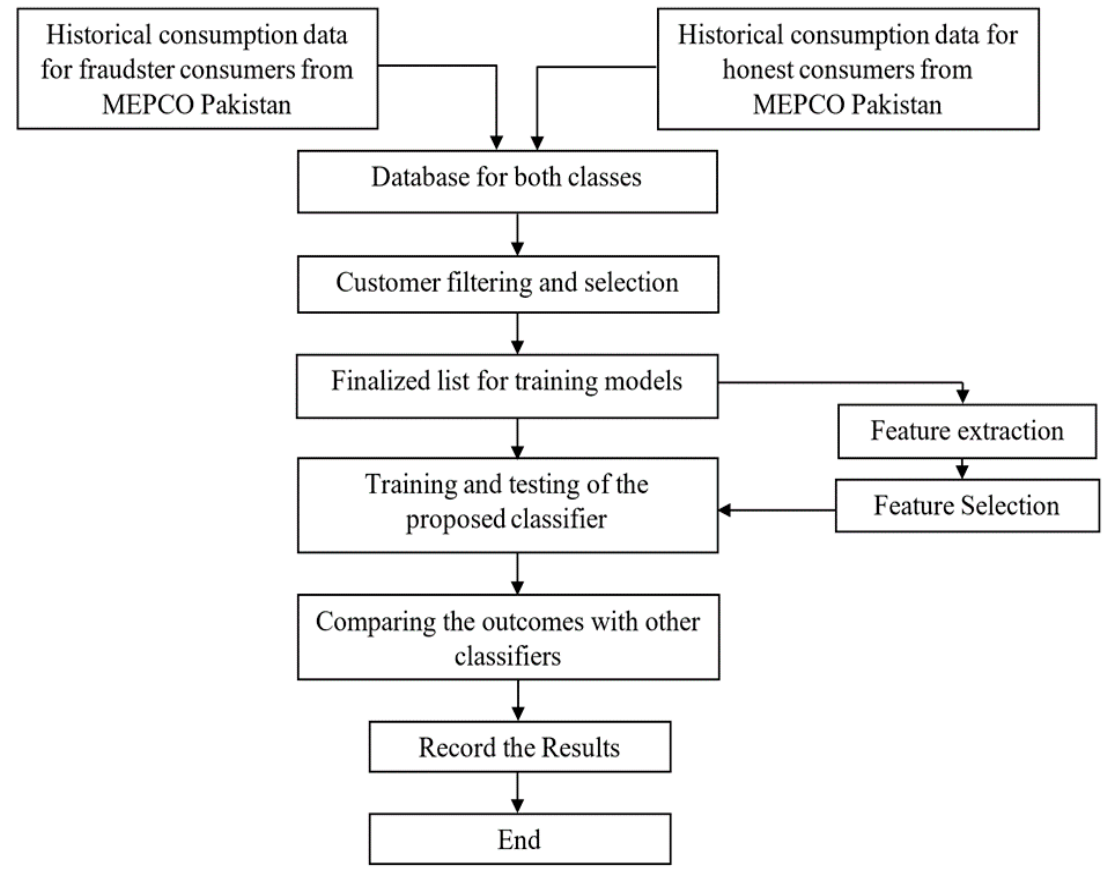
Figure 1. Flowchart of the proposed study.